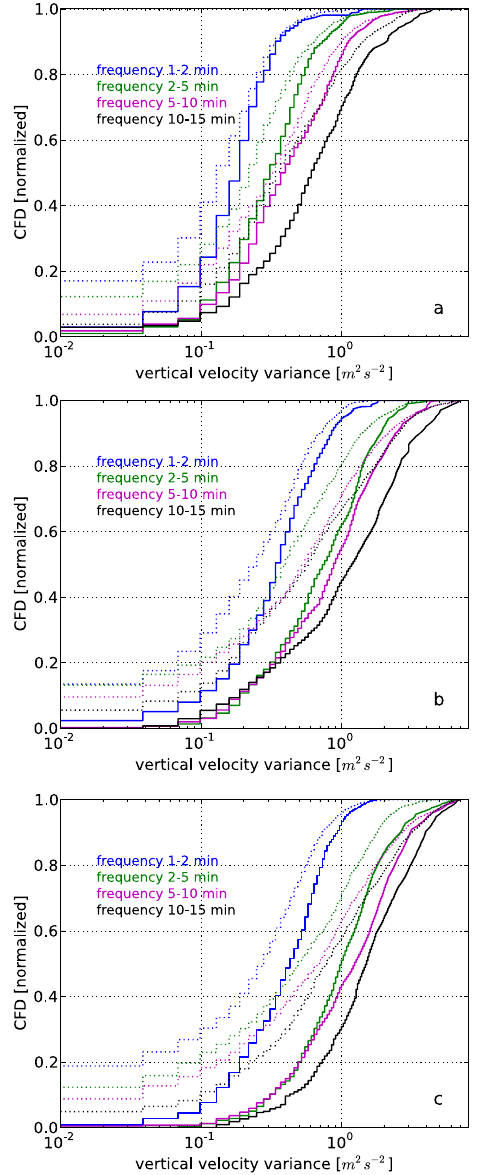
Fig. 11. Normalized cumulative frequency distributions (CFDs) of w variance [m 2 s − 2 ] at (a) cloud top level, (b) cloud mid-level and (c) cloud base level for coupled (solid) and decoupled (dashed) surface–cloud states during 25–30 August. CFDs are separated into four frequency ranges: 1–2min (blue), 2–5min (green), 5–10min (magenta) and 10–15min (black). A 15min running average has been applied to the w